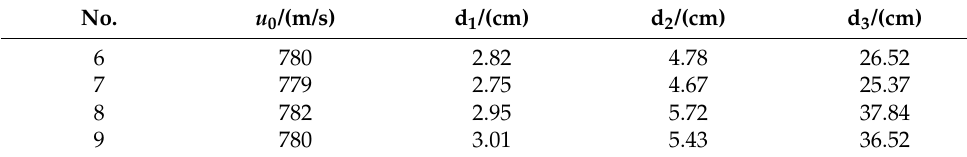
Table 7. Test results of 15-mm-thick steel target.